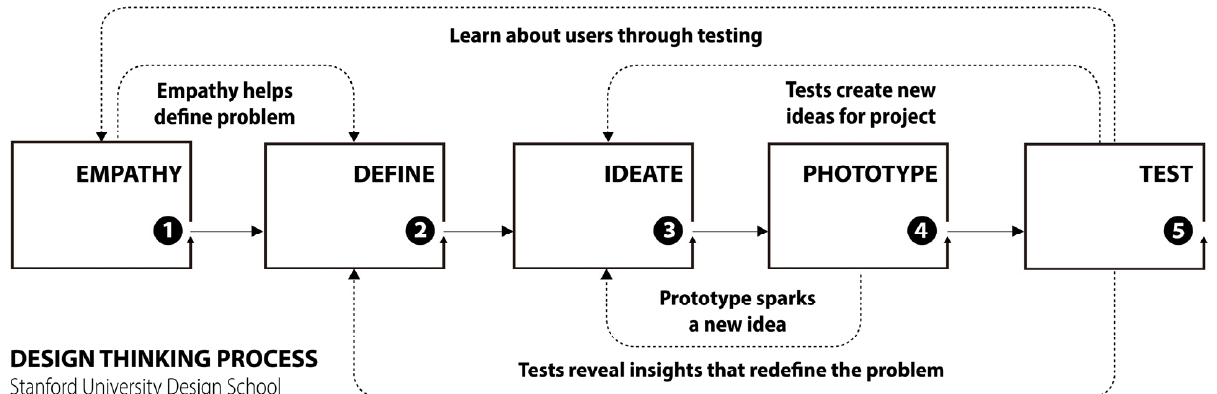
Figure 2. The Design Thinking Process model of Stanford University. (According to ref. [88], this figure is painted by this article).